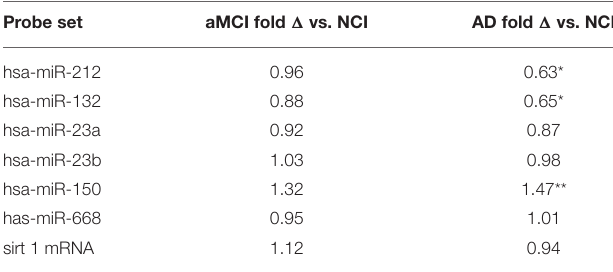
TABLE 4 | qPCR analysis of select miRNAs and sirt1 mRNA in temporal cortex of NCI, aMCI, and AD subjects. Probe set aMCI fold 1 vs. NCI AD fold 1 vs.